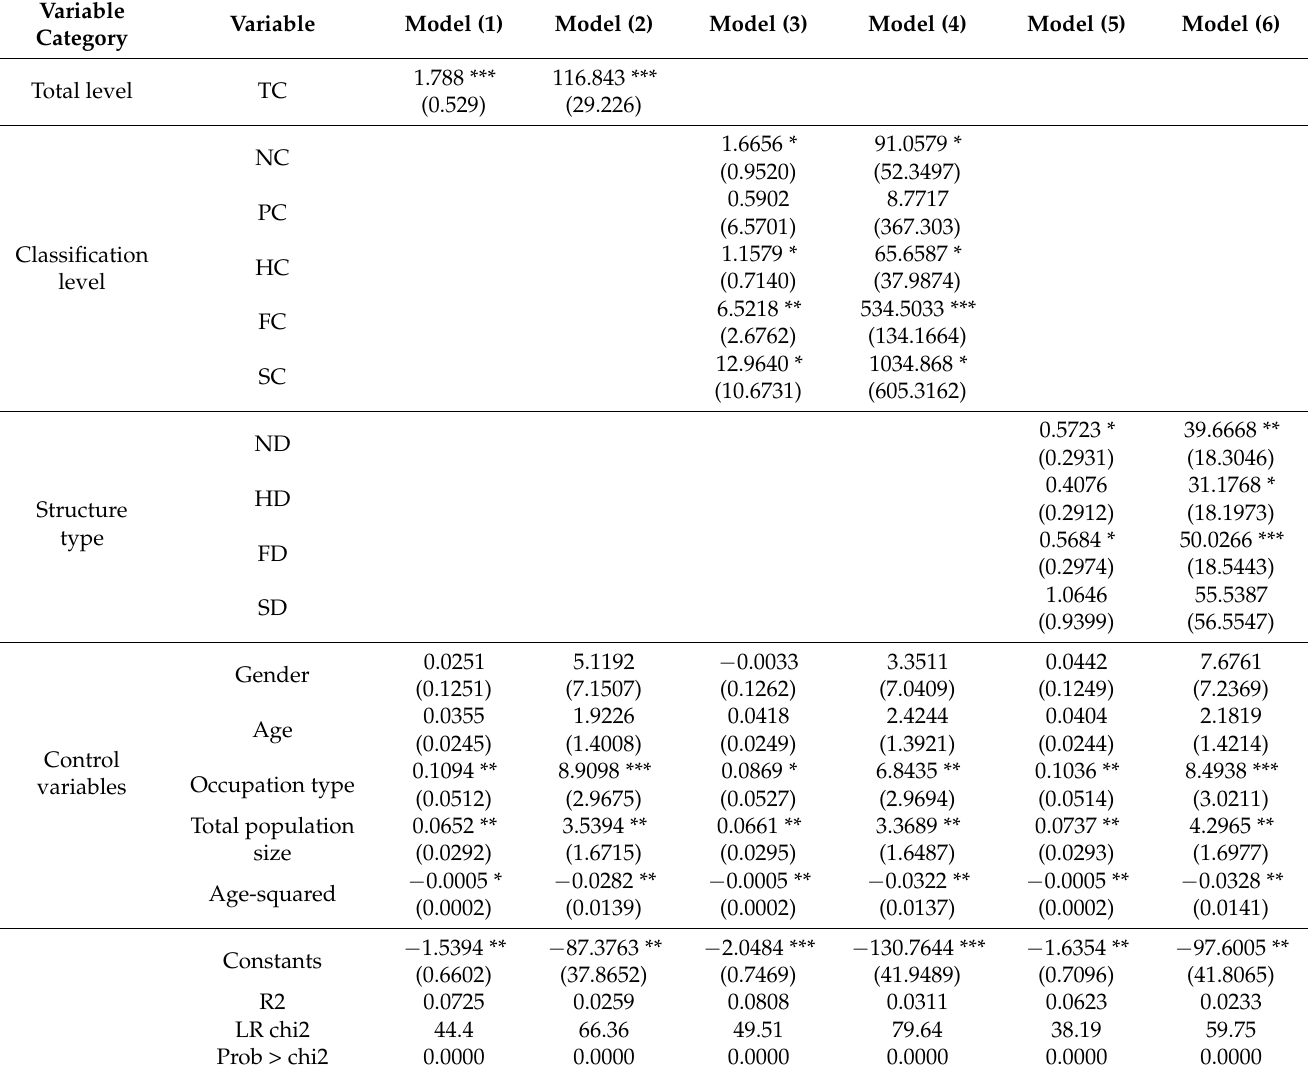
Table 7. Effect of the livelihood capital level and structure on rural households’ WTP for